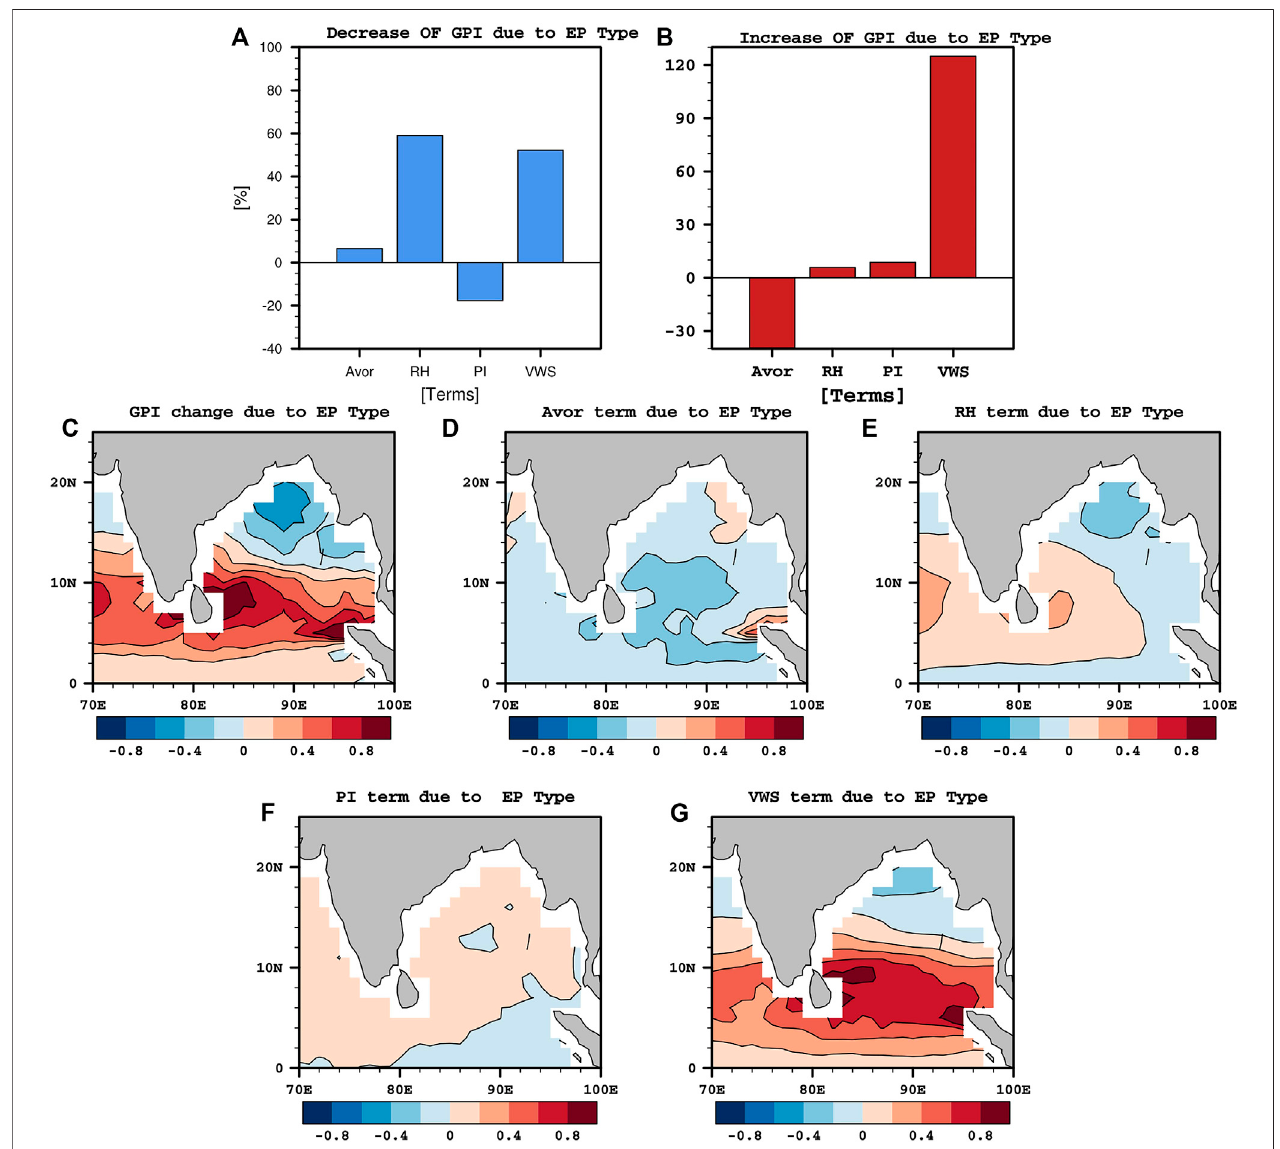
FIGURE 7 | (A) Relative contributions (percentages) of each term to the diagnosed GPI changes associated with EP El Niño over the red boxed region (5 ° – 11 ° N, 80 ° – 98 ° E)and (B) blueboxedregion(16 ° – 21 ° N,80 ° – 93 ° E)in Panel6E . (C) ThediagnosedGPIchangeintheBoBduetoEPElNiñoandthespatialdistributionofdiagnosed four large-scale terms: (D) absolute vorticity at 850 hPa (Avor), (E) relative humidity at 700 hPa (RH), (F) potential intensity (PI) and (G) vertical wind shear (VWS).